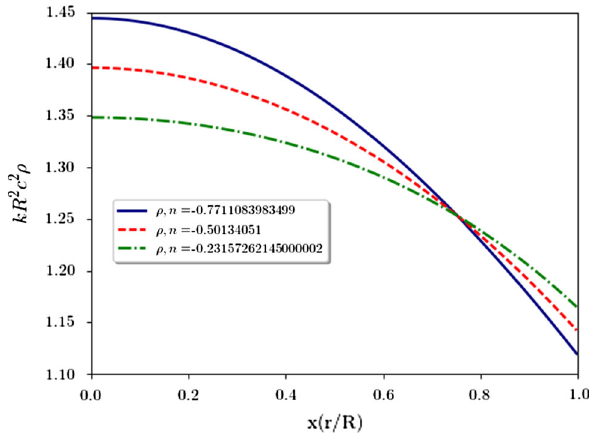
Fig. 1 Graphical representation of the radial and tangential speed of sound behavior for ( w = 0 . 423669443)